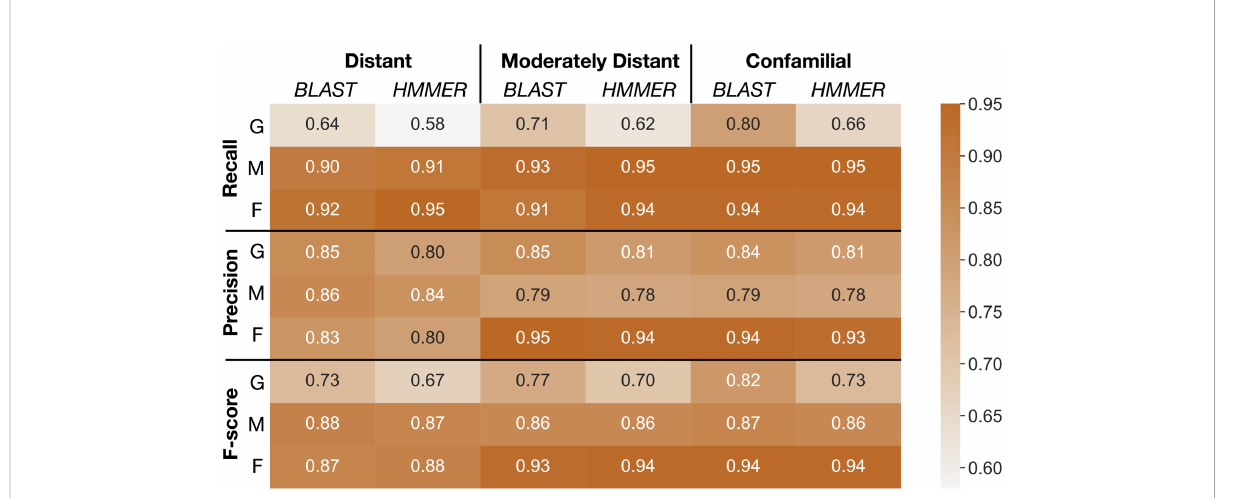
FIGURE 5 Summaries of performance evaluation of classi fi cation rates for BLAST and HMMER classi fi ers. Recall, precision, and F-score (Vihinen, 2012) for the two classi fi ers are measured on GFam (G), OrthoMCL (M), and OrthoFinder (F) clustering methods to determine how well taxa at different distances are classi fi ed into the PlantTribes2 22Gv1.1 gene family scaffold. Larger values are better. Distant: remove and sort back Physcomitrella patens , a species distantly related to all other scaffolding species; Moderately distant: remove Solanum lycopersicum and S. tuberosum , then sort back S. lycopersicum . No other Solanaceae species are present in the scaffold, but moderately distant species, i.e. , other asterids, are used as scaffolding species; Confamilial: S. lycopersicum was removed and sorted back. A confamilial species, S. tuberosum , is present in the